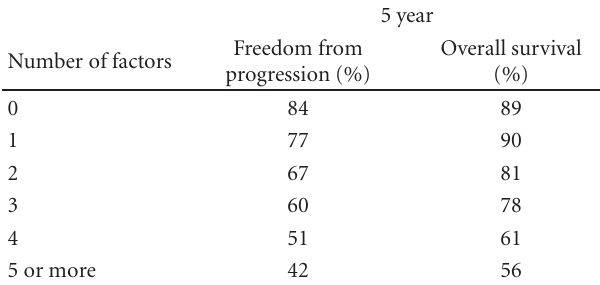
Table 2: Outcome for advanced Hodgkin’s lymphoma based on International Prognostic Score. Risk factors: age > 45y, stage